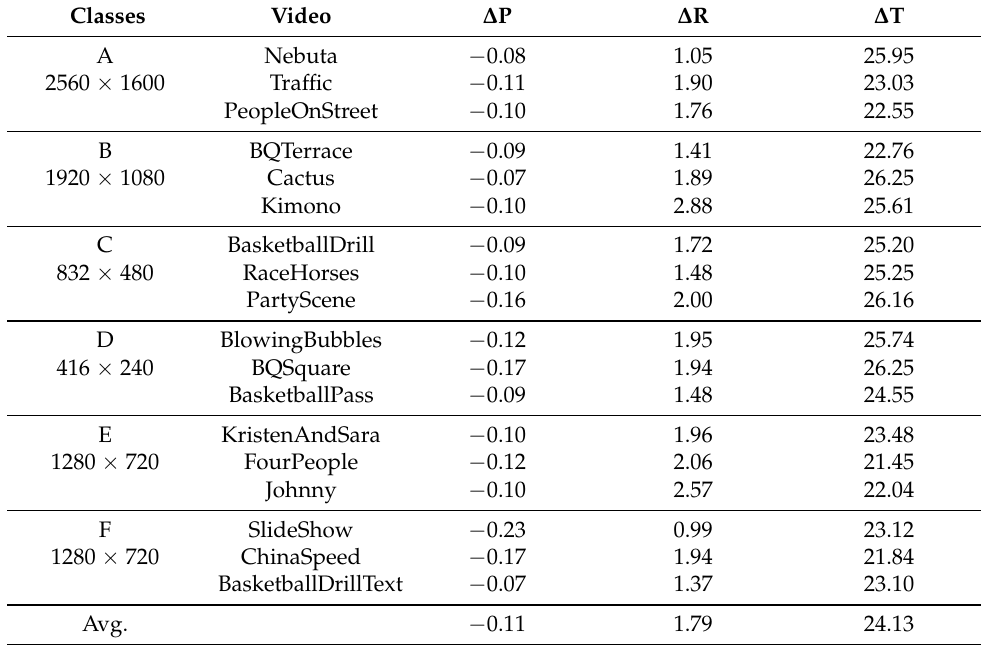
Table 3. Result of proposed algorithm given in